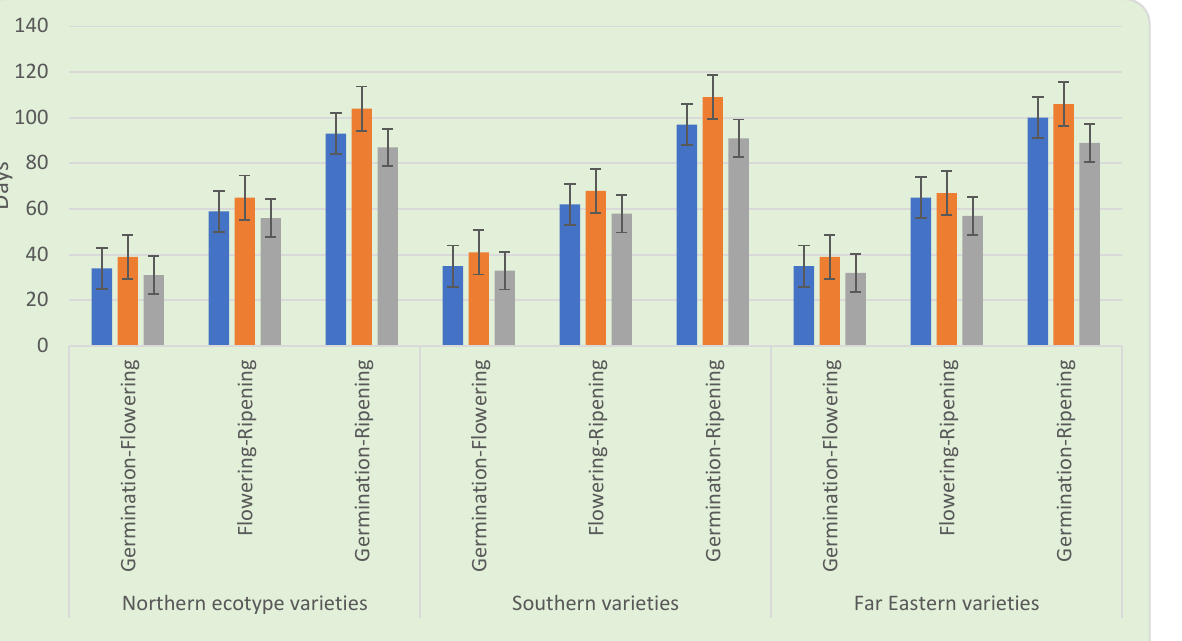
Figure 5. The duration of the growing season for soybean varieties of different ecological and geo- graphical origin, depending on the humidification conditions (Ryazan Oblast, 2008–2020).